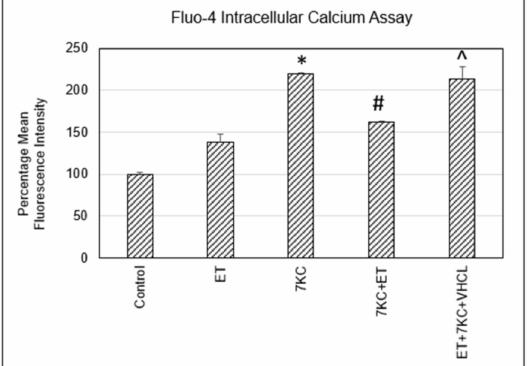
Figure 3. 7KC induced an increase in intracellular free calcium as detected by Fluo-4 assay using flow cytometry. This increase was significantly modulated by ET. Addition of VHCL abrogated the increase in intracellular free calcium. ET: 1 mM ET; VHCL: 100 µ M VHCL; 7KC: 30 µ M 7KC. Data are represented as the mean ± SD (n = 6). * Significant difference compared to controls ( p < 0.05). # Significant difference compared to 7KC. ˆ Significant difference compared to ET + 7KC. Data were analysed by one-way ANOVA with Bonferroni’s multiple comparison post-hoc